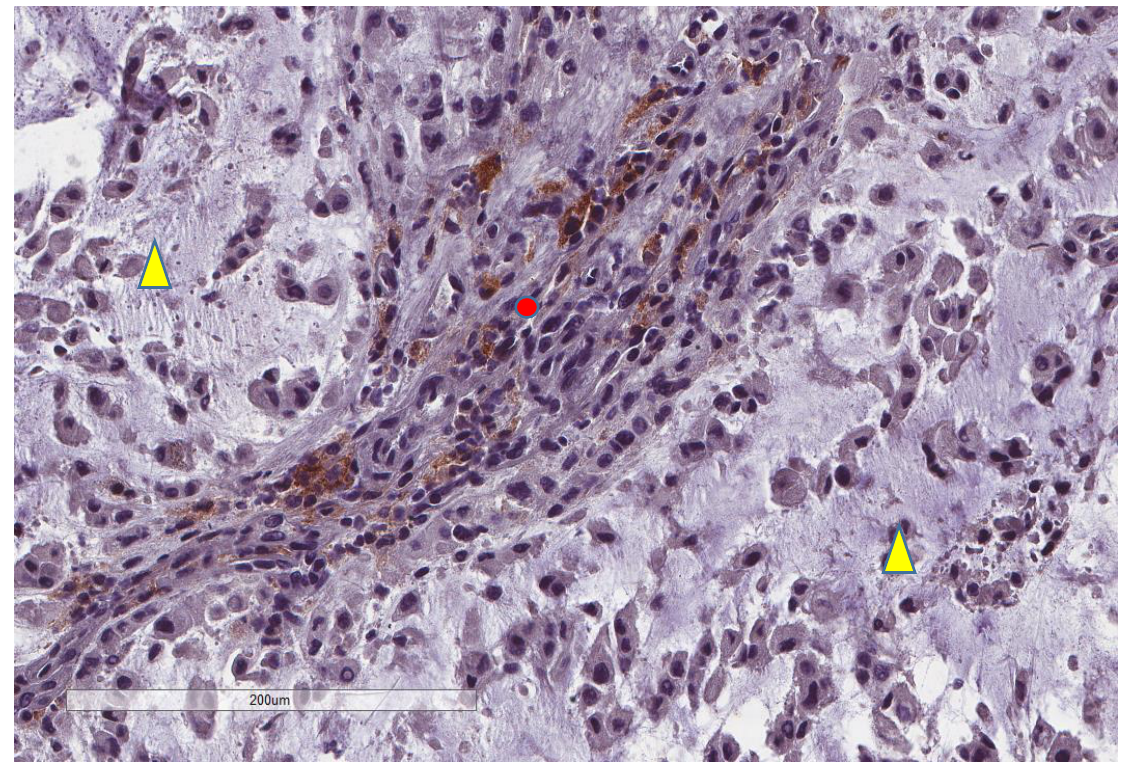
Figure 8. Representative microscopic image (×200 magnification) showing PD-L1 expression by immune cells (red circle) but not tumor cells (yellow triangle).